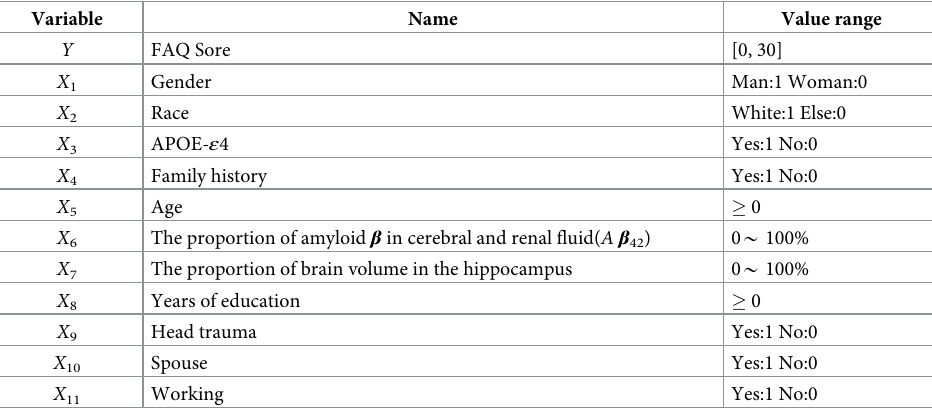
Table 5. Variable